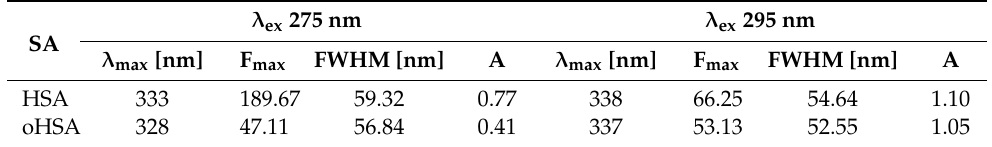
Table 1. Fluorescence of unmodified (HSA) and oxidized (oHSA) human serum albumin